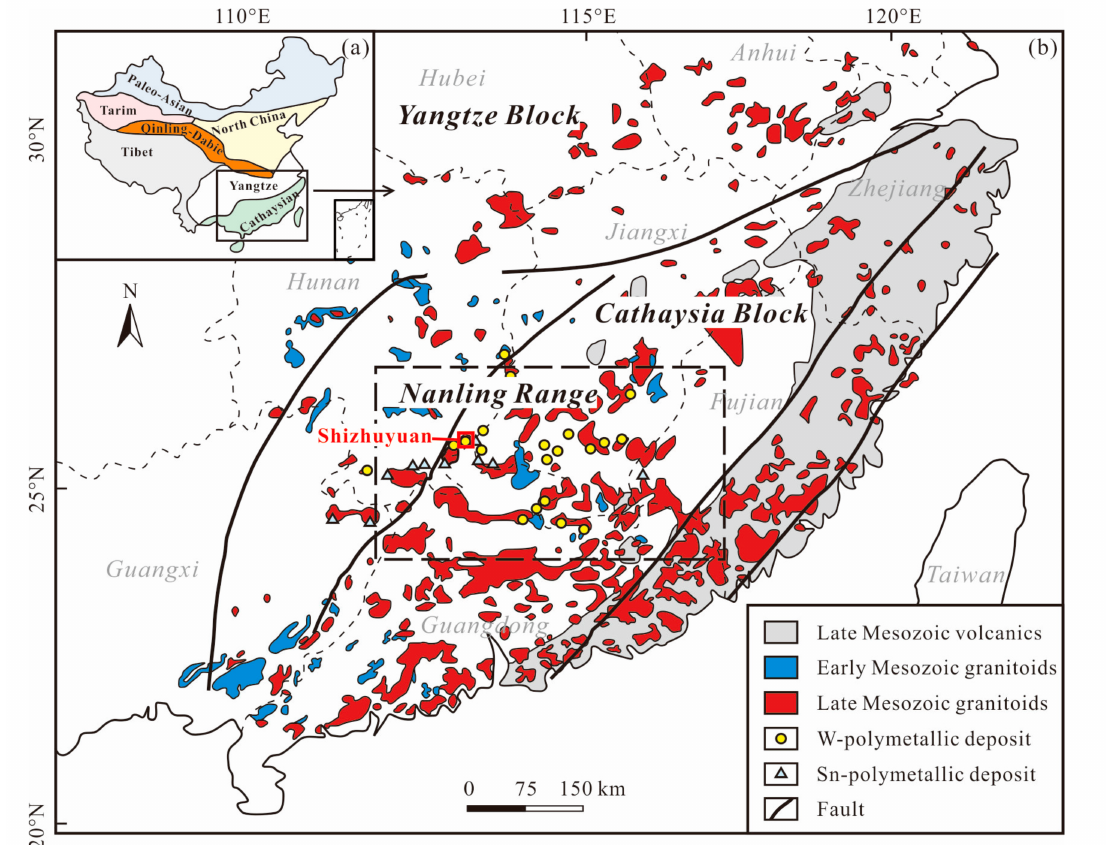
Figure 1. ( a ) Simplified tectonic outline of China where the South China Block (SCB) is separated into the Yangtze Block and the Cathaysia Block; ( b ) Geological sketch map of the SCB showing the distribution of Mesozoic granites and the Nanling Range with numerous W-Sn polymetallic deposits (modified after Chen et al. [16] and Jiang et al.